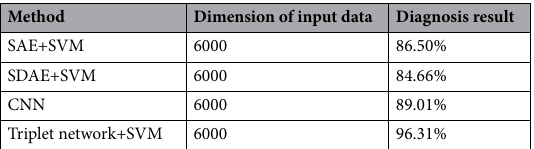
decoder contains 3 deconvolution layers to restore the 64-dimensional space vector to vibration data. We use Gaussian kernel function, the penalty coefficient is 1, and the Gamma value is 1/64. The 64-dimensional space vector output by the Encoder is input to the SVM classifier for classification.